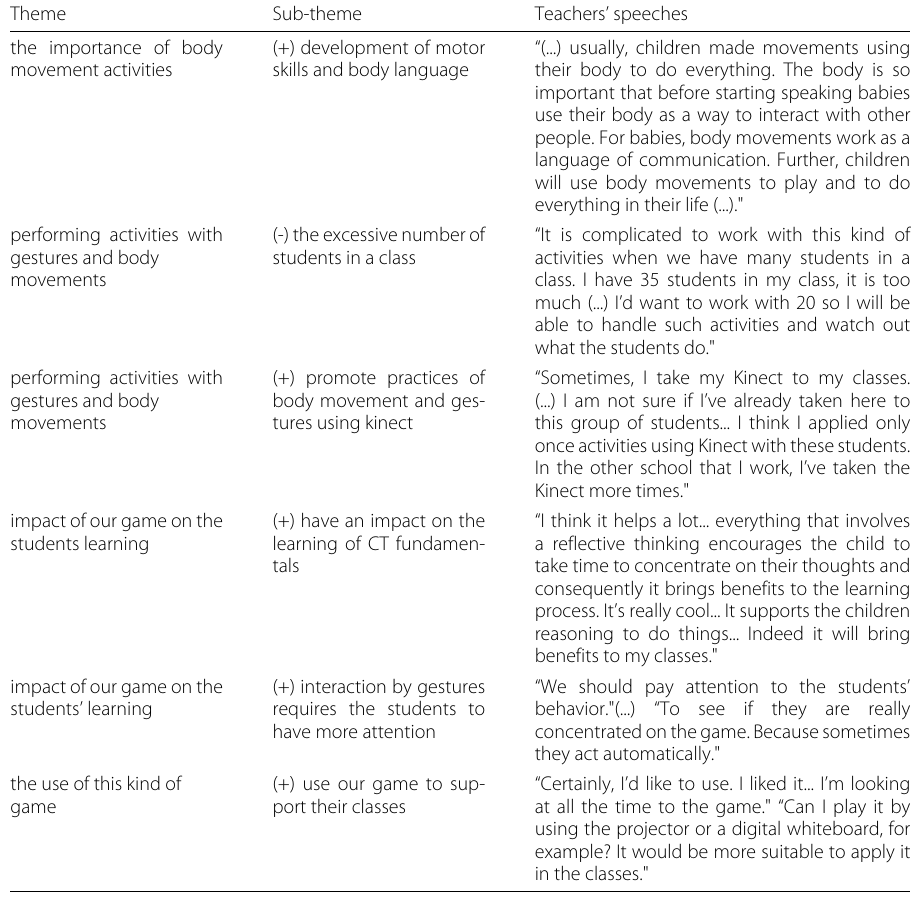
Table 5 Themes, sub-themes and teachers’ speeches